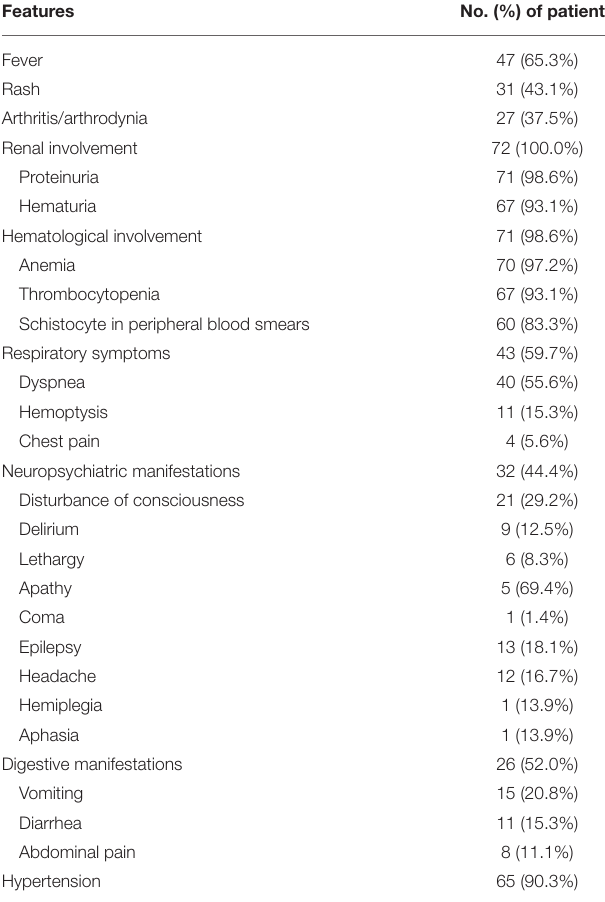
TABLE 1 | Frequencies of clinical features in 72